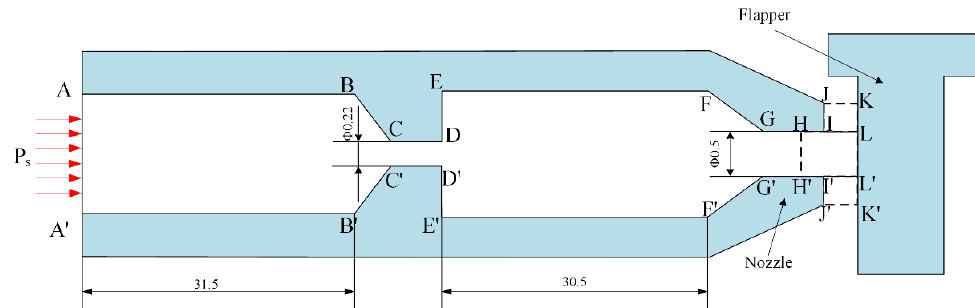
Figure 10. Jet structure of the pilot stage.